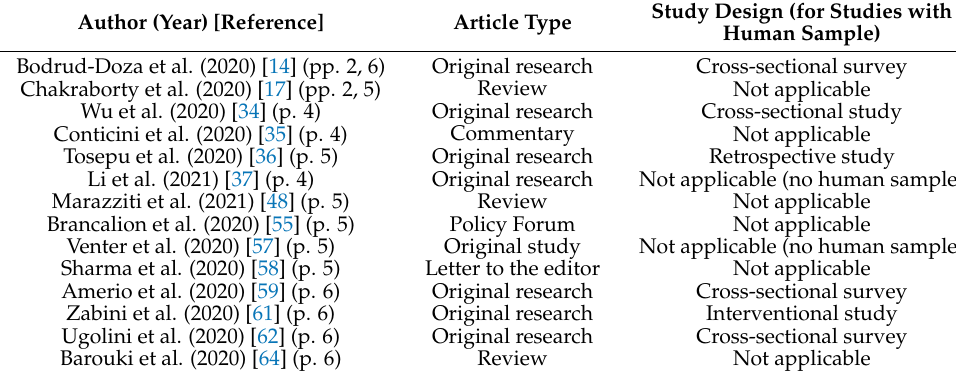
Table A1. Papers evaluating the relationship between air pollution and related phenomena, the COVID-19 pandemic and mental health.